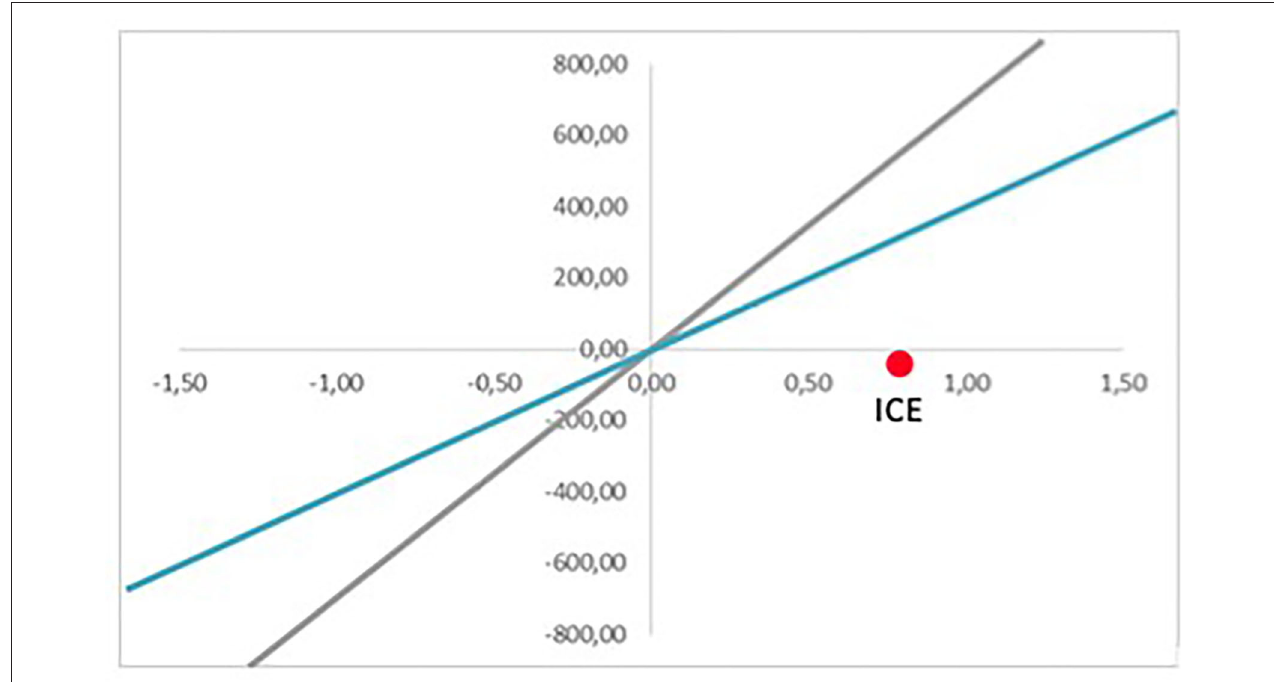
FIGURE 8 | Cost-effectiveness plan (Scenario 2).